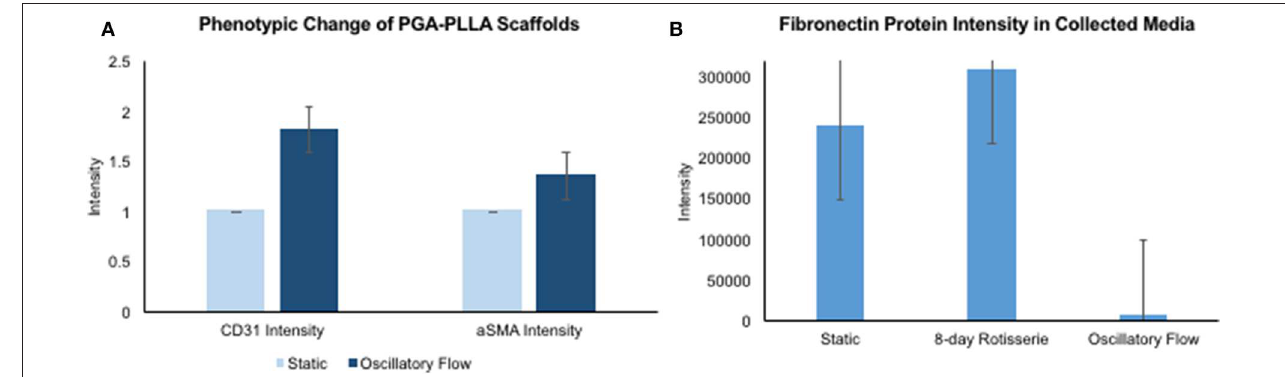
FIGURE 11 | hBM-MSCs differentiation toward α -SMA and CD31 valvular phenotypes and fibronectin protein intensity in collected media. PGA-PLLA scaffolds seeded with hBM-MSCs demonstrating (A) average intensity values of α -SMA and CD31 in static and oscillatory flow groups. There was a significant difference ( p < 0.05) in both α -SMA and CD31 phenotypes intensities between the groups. In the oscillatory flow group there was an increase in both α -SMA and CD31 compared to the static group (significant, p < 0.05). (B) Media was collected and fibronectin intensities were assessed for static, 8-day rotisserie and oscillatory flow groups. The oscillatory flow group was significantly lower ( p < 0.05) than both the static and 8-day rotisserie groups. P -values and boxplots for specific statistical analysis can be seen in Supplementary Figures B–D .